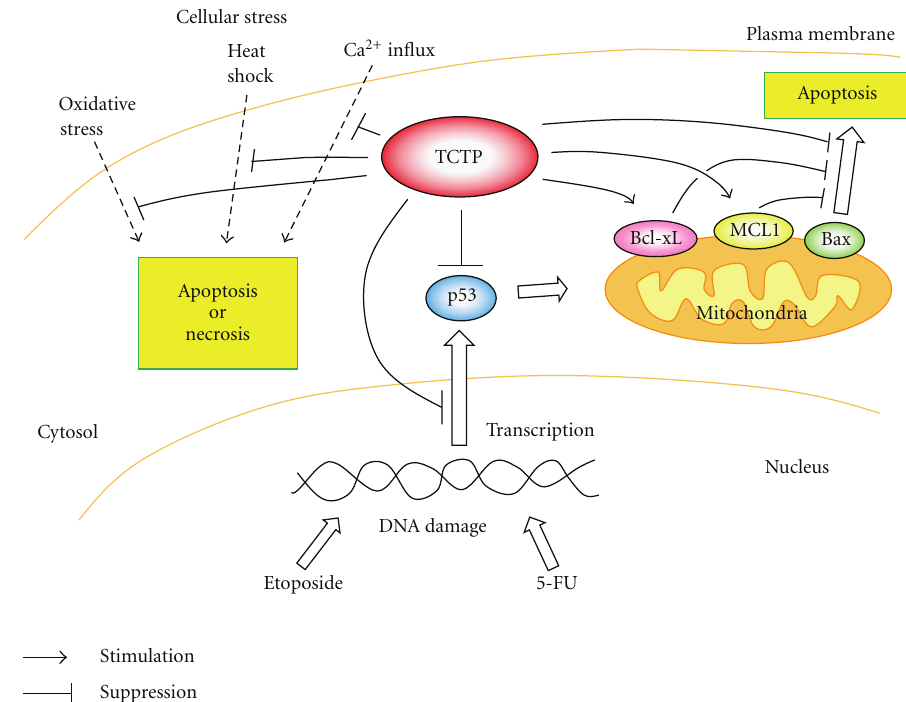
Figure 1: TCTP protects cells from cell death. TCTP inhibits cell death induced by oxidative stress, heat shock, or influx of Ca 2+ . In addition, TCTP can protect cells from apoptosis triggered by treatment with genotoxic reagent such as etoposide and 5-fluorouracil. TCTP inhibits apoptosis by stabilizing antiapoptotic Bcl-2 family proteins, MCL1 and Bcl-xL and by inhibiting activation of proapoptotic Bcl-2 family protein, Bax. Moreover, TCTP inhibits p53-dependent apoptosis by downregulating the